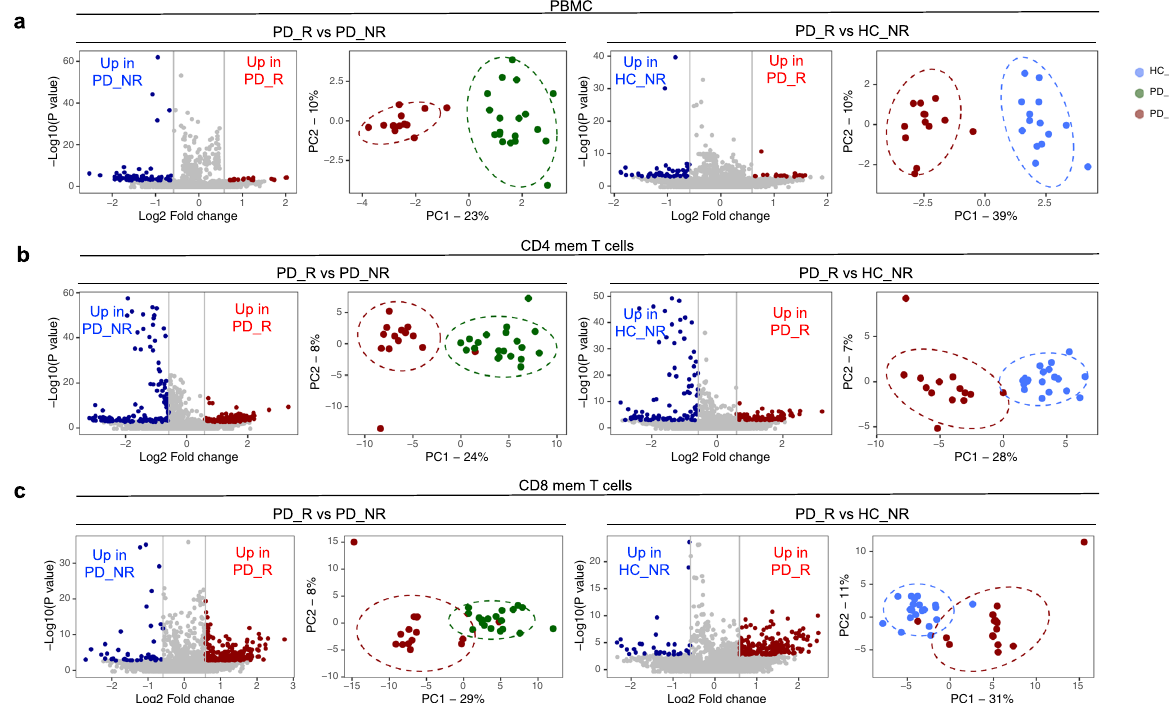
Fig. 2 α -syn speci fi c T cell reactivity is associated with a unique gene expression pro fi le. Volcano plots show log 2 fold change vs. − log 10 ( P value) for the PD_R ( n = 15) vs. PD_NR ( n = 21) and PD_R vs. HC_NR ( n = 20), respectively. The subset of genes with an absolute log2 fold change >1.5 and adjusted p -value less than 0.05 were considered signi fi cant and are indicated by dotted lines. Red dots of volcano plots indicate protein-coding genes upregulated in PD_R and blue dots indicate protein-coding genes downregulated in PD_NR or HC_NR. PCA plots show distinct clusters of PD_R, PD_NR and HC_NR ( a ) PBMC ( b ) CD4 memory T cells ( c ) CD8 memory T cells based on differentially expressed protein-coding